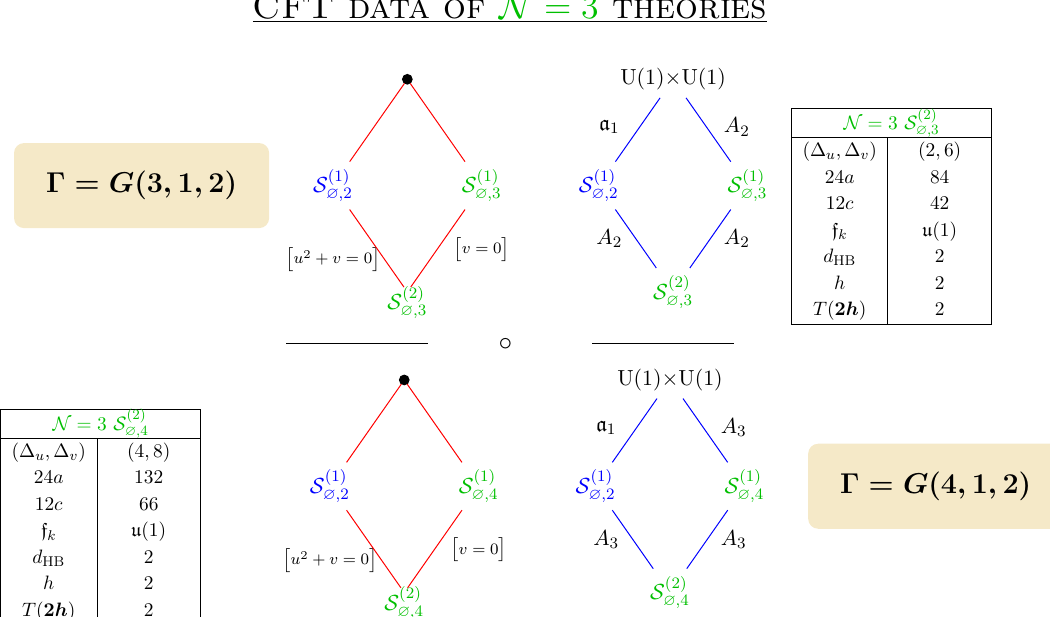
Figure 49. CFT data for N = 3 rank-2